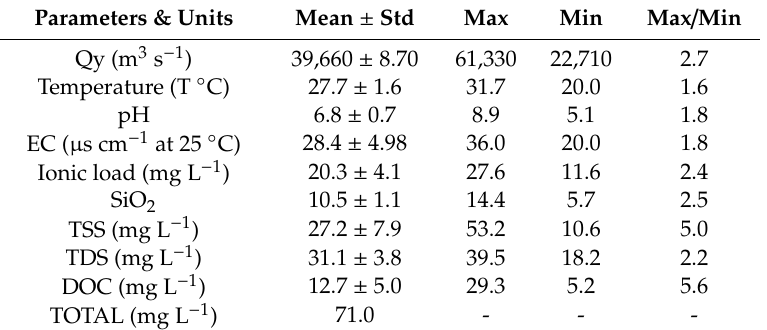
Table 2. Interannual Yearly discharge (Qy) and main surface water quality parameters for the Congo River at BZV / KIN gauging station, for the 2006–2017 period.